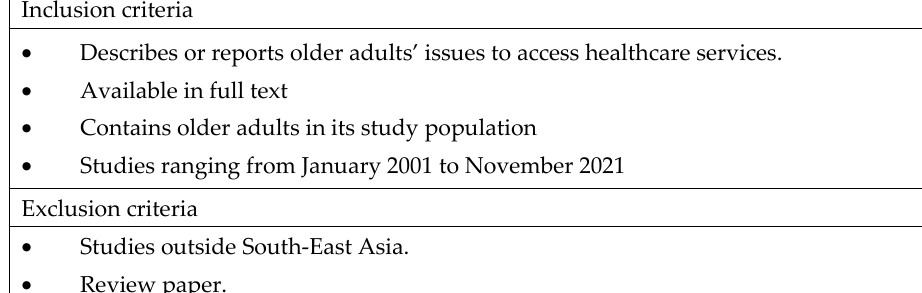
Figure 1. PRISMA flow diagram. The PRISMA diagram details the search and selection process applied during our systematic literature search for this scoping review. PRISMA, Preferred Reporting Items for Systematic Reviews and